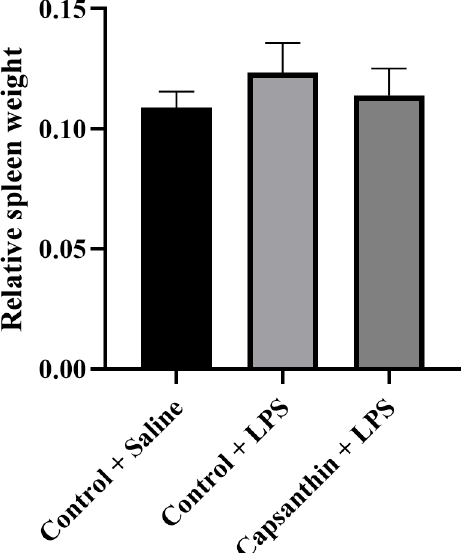
Figure 1. Relative spleen weight of broiler chickens. Con- trol + saline: chickens fed a basal diet with isotonic saline injection. Control + LPS: chickens fed a basal diet under E. coli O55:B5 LPS challenge. Capsanthin + LPS: chickens fed a diet supplemented with capsanthin at 80mgkg − 1 under E. coli O55:B5 LPS chal- lenge ( n = 6 / treatment). Data are presented as means ± standard errors of the mean. The impact was analyzed by one-way ANOVA, and differences among the groups were considered significant at P< 0 . 05. The effect of dietary supplementation was not significant.